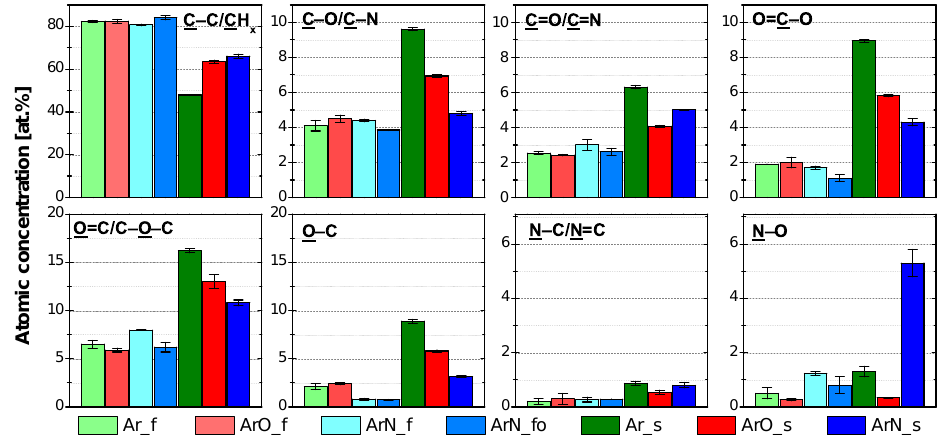
Figure 8. XPS C1s, O1s, and N1s high-resolution spectrum components and their atomic concentra- tions for the plasma-treated PP samples. Spectra were measured 24 h after plasma